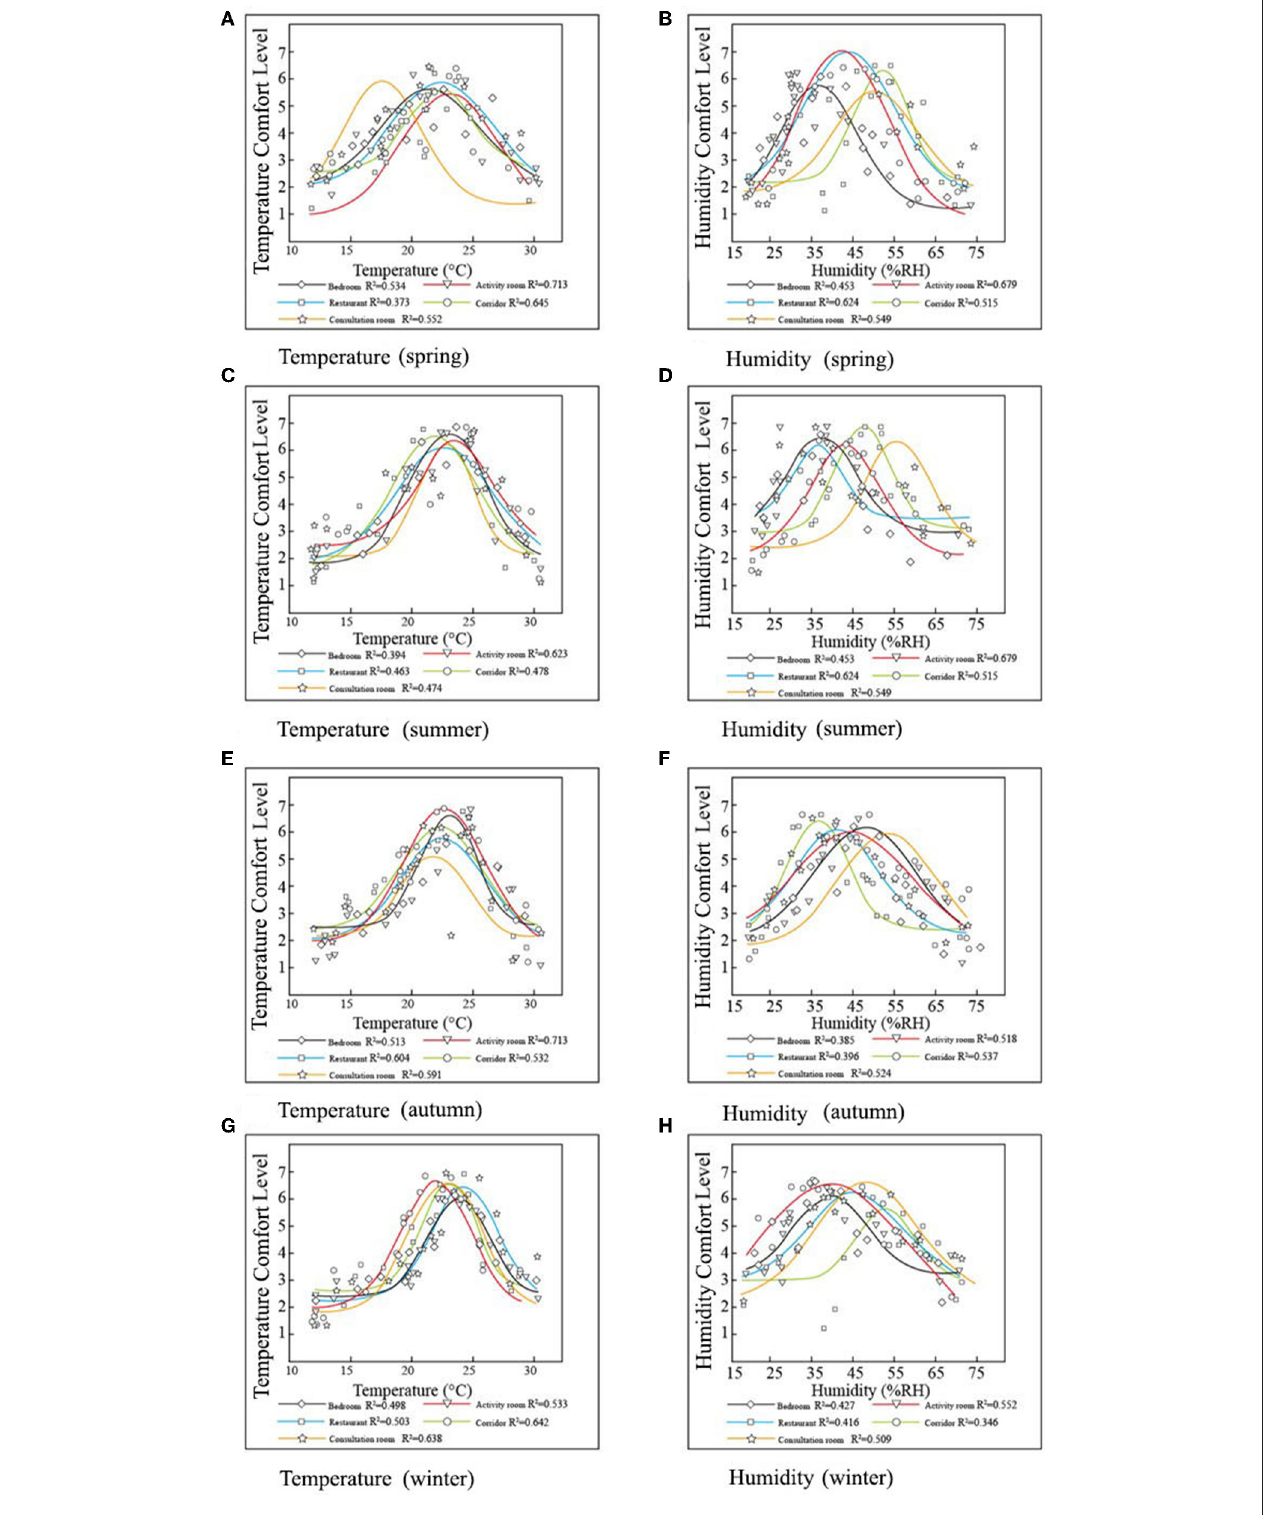
FIGURE 10 | The fit between thermal indicators and thermal evaluation for 4 RECFs. (A) Temperature (spring), (B) Humidity (spring), (C) Temperature (summer), (D) Humidity (summer), (E) Temperature (autumn), (F) Humidity (autumn), (G) Temperature (winter), and (H) Humidity (winter).